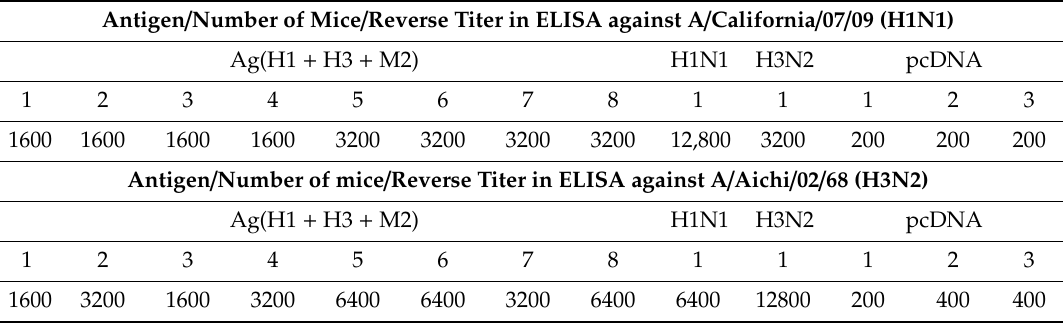
Table 3. Titers of anti-influenza virus antibodies assessed with ELISA in immunized mice sera.